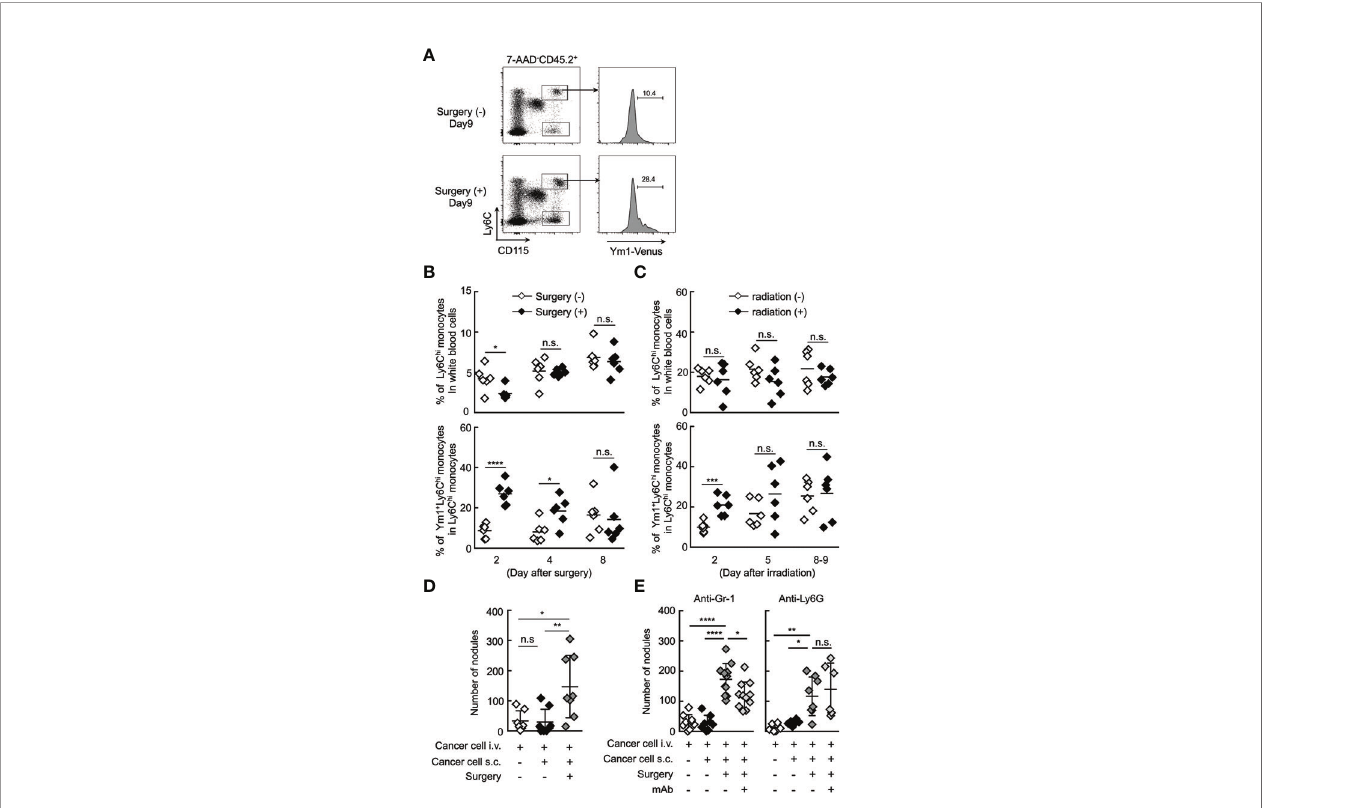
FIGURE 5 | Ym1 + Ly6C hi monocytes contribute to the promotion of lung metastasis induced by tumor resection. (A, B) Increased frequency of Ym1 + Ly6C hi monocytes after tumor resection. B16 cells (1 x 10 6 cells) were subcutaneously (s.c.) inoculated in the fl ank of Ym1-Venus mice. Seven days later, the primary tumor was removed by surgery. (A) The frequency of monocytes in peripheral blood were analyzed at the indicated time points. Representative fl ow cytometric pro fi les of the percentage of Ym1 + cells in Ly6C hi monocytes on day 9. (B) Percentage of Ly6C hi monocytes in white blood cells (upper) and Ym1 + cells in Ly6C hi monocytes (lower) in peripheral blood. Unpaired two-tailed t-test, n = 5-6. **** P < 0.001; * P < 0.05; n.s., not signi fi cant. (C) Increased frequency of Ym1 + Ly6C hi monocytes after radiation exposure to primary tumor. B16 cells (1 x 10 6 cells) were subcutaneously (s.c.) inoculated in the fl ank of Ym1-Venus mice. Seven to eight days later, the animals were randomized into one of two treatment groups: no irradiation or 30 Gy irradiation. The frequency of monocytes in peripheral blood were analyzed at the indicated time points. Percentage of Ly6C hi monocytes in white blood cells (upper) and Ym1 + cells in Ly6C hi monocytes (lower) in peripheral blood. Unpaired two- tailed t-test, n = 6. *** P < 0.005; n.s., not signi fi cant. Each symbol represents an individual animal. (D) Increased number of lung metastases after tumor resection. B16 cells (1 x 10 6 cells) were s.c. inoculated in the fl ank of WT mice. Seven days later, the primary tumor was removed by surgery followed by i.v. injection of B16 cells (1 x 10 5 cells) 24 h later. The lungs were analyzed for metastasis on Day 16. Quantitative summary of the number of lung metastases. Average values are shown with SD. One-way ANOVA followed by Dunnett ’ s test, n = 7-8. ** P < 0.01; * P < 0.05; n.s., not signi fi cant. Each symbol represents an individual animal. (E) Effects of immune cell deletion on lung metastasis after tumor resection. B16 cells (1 x 10 6 cells) were s.c. inoculated in the fl ank of WT mice. Seven days later, the primary tumor was removed by surgery followed by i.v. injection of B16 cells (1 x 10 5 cells) 24 h later. For deletion of Ly6C hi monocytes and neutrophils (anti-Gr- 1), or neutrophils alone (anti-Ly6G), 50 µg/daily of indicated mAbs or PBS were injected into these mice from Day 6 to Day 15. The lungs were analyzed for metastasis on Day 16. Quantitative summary of the number of lung metastases. Average values are shown with SD. One-way ANOVA followed by Dunnett ’ s test, n = 6 – 11. **** P < 0.001; ** P < 0.01; * P < 0.05; n.s., not signi fi cant. Each symbol represents an individual